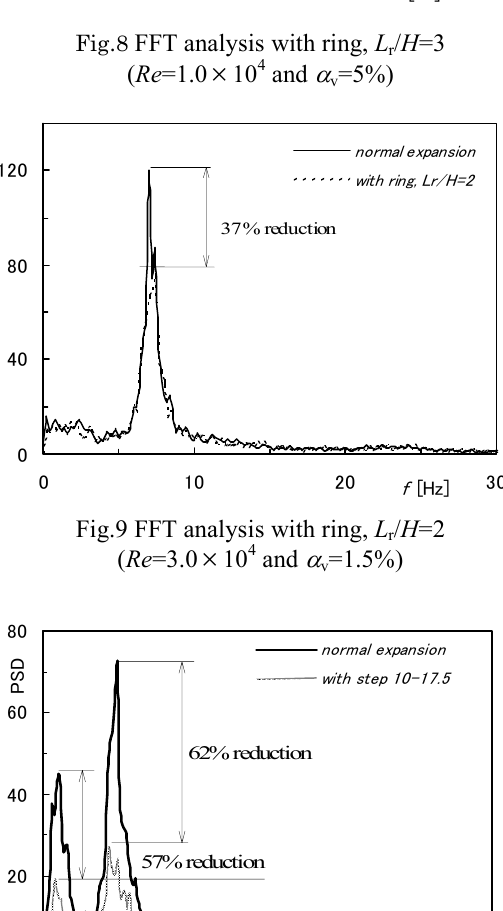
Fig.8 FFT analysis with ring, L r / H =3 ( Re =1.0 × 10 4 and α